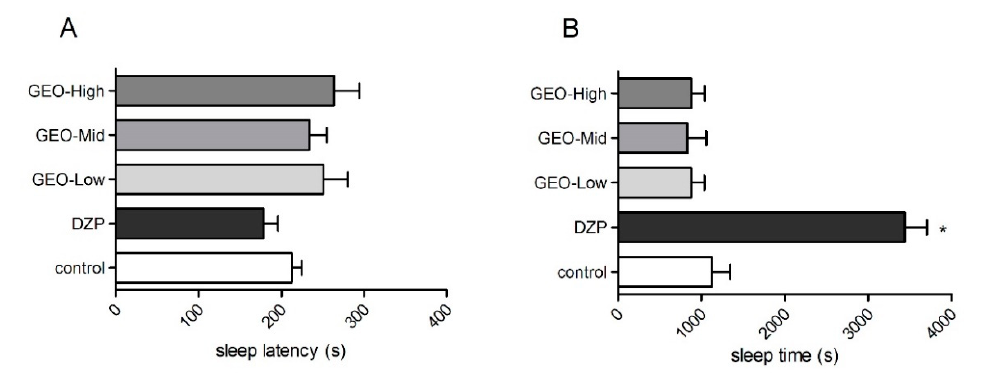
Figure 3. The effects of GEO odor exposures on the mice in pentobarbital sodium sleep test. Sleep latency ( A ) and sleep time ( B ) after GEO exposure with three concentrations (GEO-Low: 0.2 mg/L, GEO-Mid: 1.0 mg/L, GEO-High: 2.0 mg/L) were recorded. Values represent the mean ± SE ( n = 8), * p < 0.05 vs. control group. One-way ANOVA followed by a post hoc Duncan test was used.